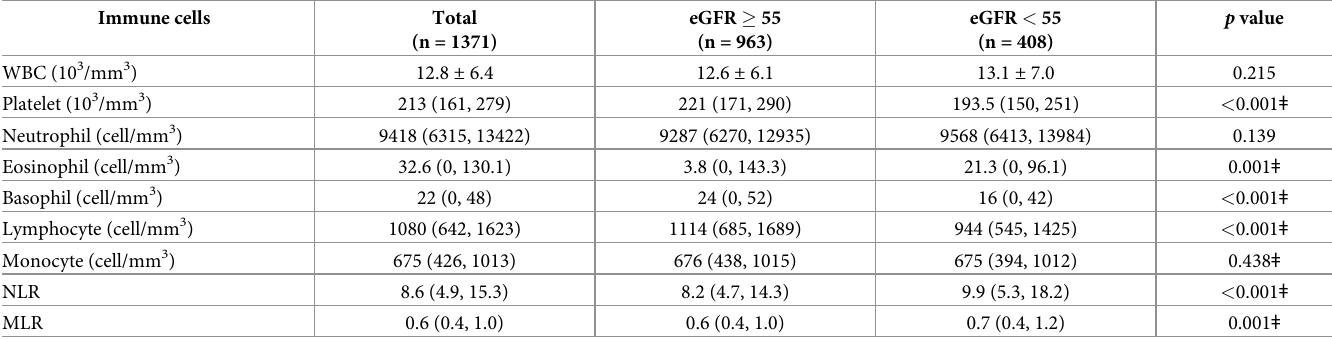
Table 3. The immune cell profiles of patients hospitalized with pneumonia categorized by